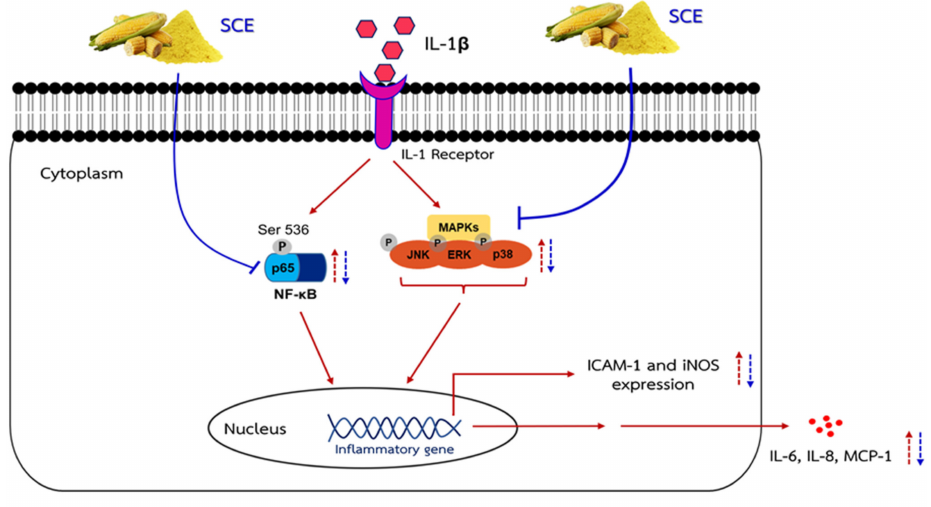
Figure 8. A schematic presentation of the proposed mechanism. IL-1 β activated MAPK and NF- κ B signaling pathways, which lead to increasing the iNOS and ICAM-1 expression and IL-6, IL-8, and MCP-1 secretion during inflammation in ARPE-19 cells. SCE treatment can decrease iNOS and ICAM-1 expression and decrease IL-6, IL-8, and MCP-1 secretion through inhibiting activation of the MAPK and NF- κ B